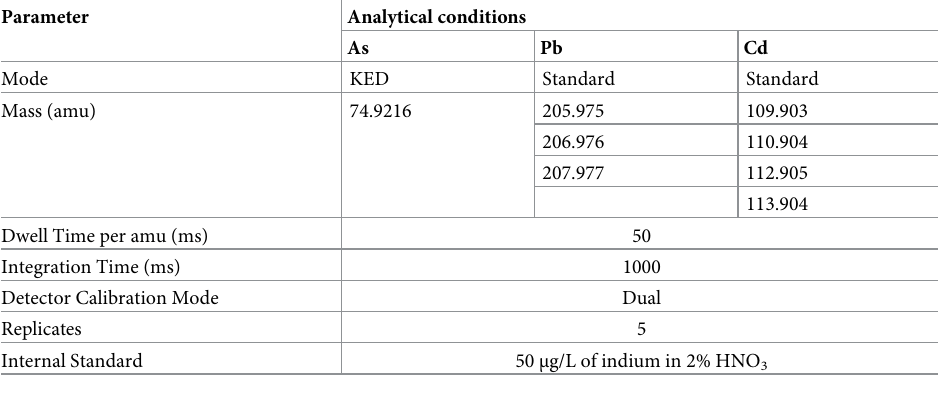
Table 2. ICP-MS conditions for As, Pb, Cd